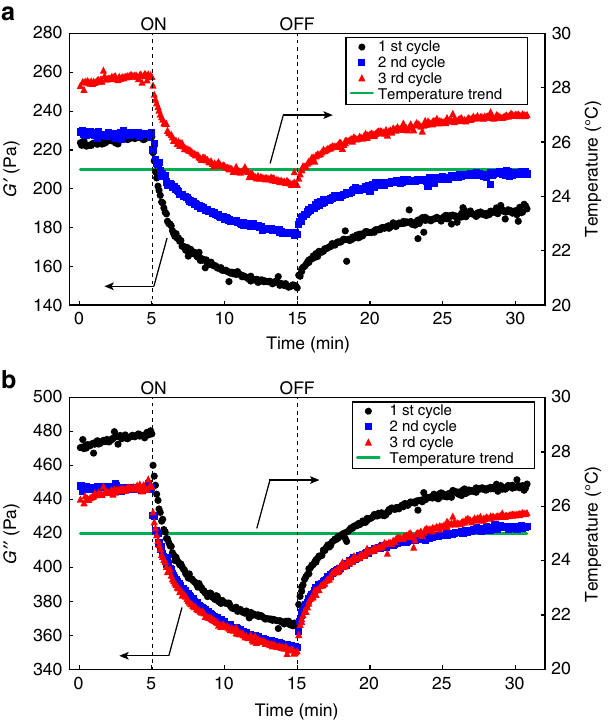
Fig. 5 Rheological properties upon repetitive UV irradiations. Time- dependent plots of a G ‘ and b G “ for network-PDMS HABI upon repeating UV irradiation cycles (1st cycle: black circle , 2nd cycle: blue square , and 3rd cycle: red triangle ) with monitoring temperature ( green line ). The starting (ON) and terminating (OFF) times of UV irradiation were indicated with dashed